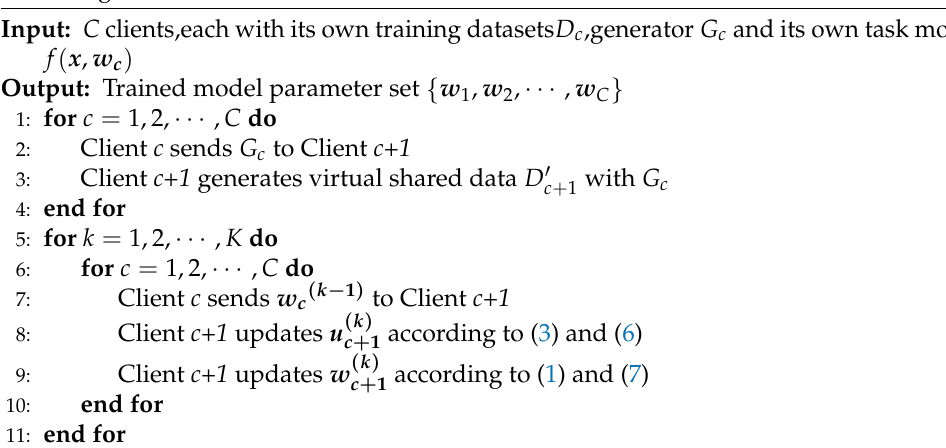
Algorithm 1 Federated learning algorithm based on distribution information sharing and knowledge